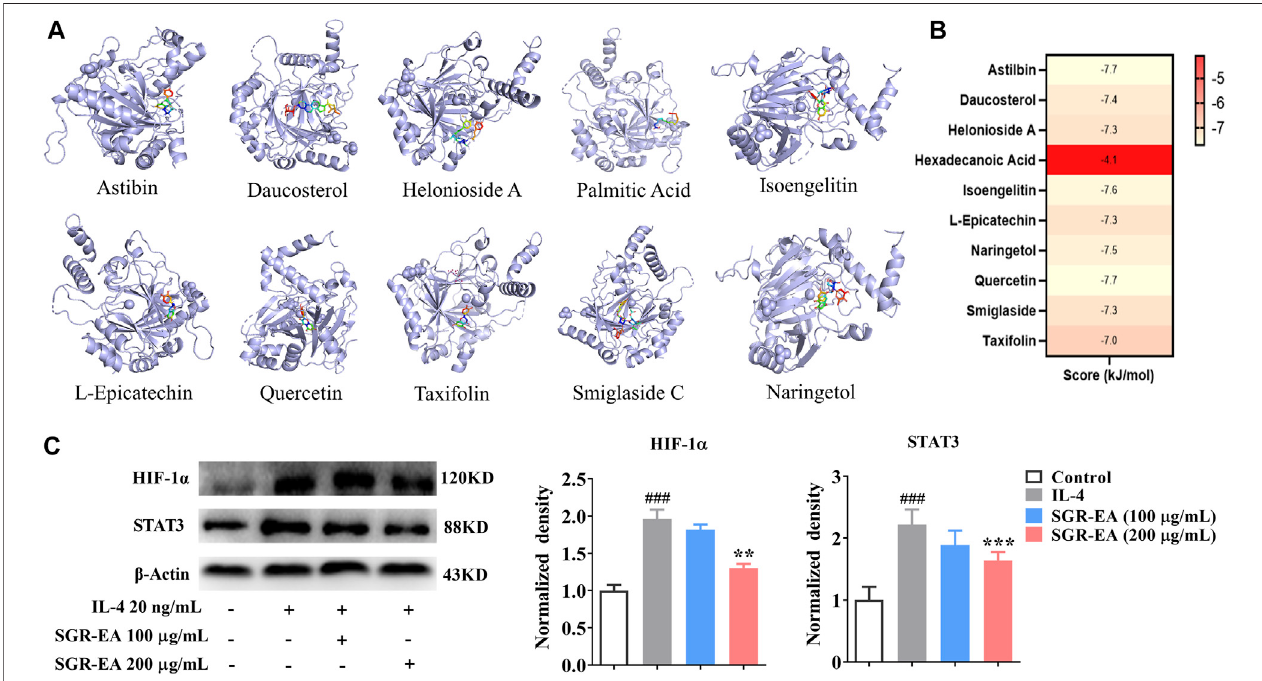
FIGURE 6 | In vitro experiments verify that SGR-EA regulates macrophage M2 polarization through the HIF-1 signaling pathway. (A) Docking mode between core active components and the target protein. (B) Molecular docking results for all compounds benchmarking pleconaril. (C) Levels of HIF-1 α and STAT3 proteins as